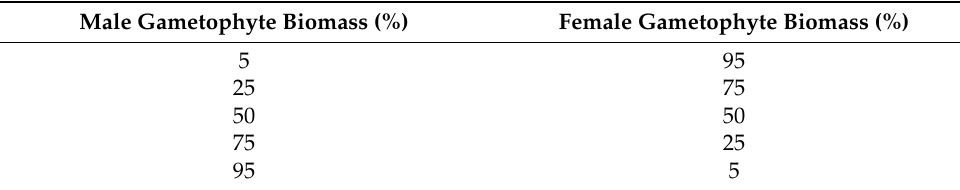
Table 1. The ratios of male:female biomass used in the experiments, which are further described in Figures 2 and